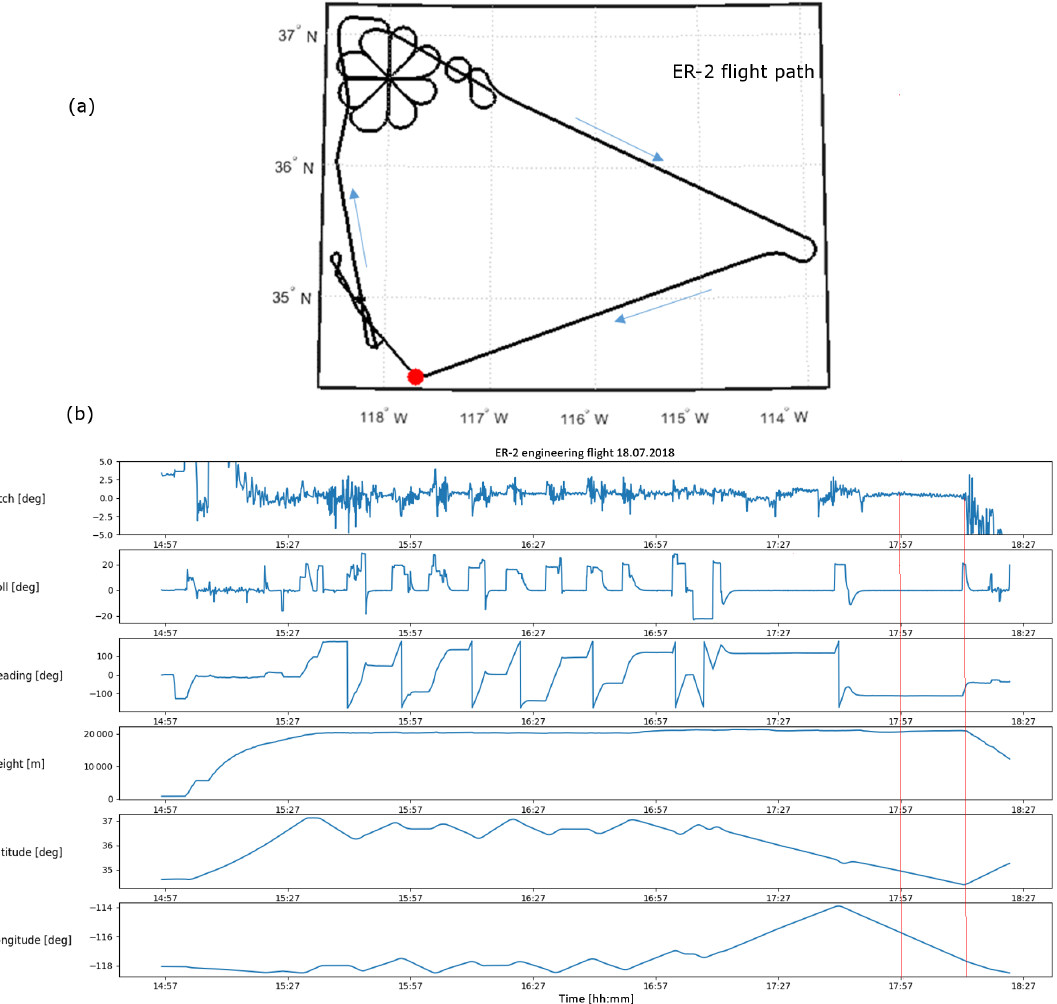
Figure 9. ER-2 flight track where the red dot indicates the location of the JPL Table Mountain facility (a) and the corresponding flight attitude information (b) for the engineering flight performed on 18 July 2017. The blue arrows indicate the forward direction of the airplane during the flight.